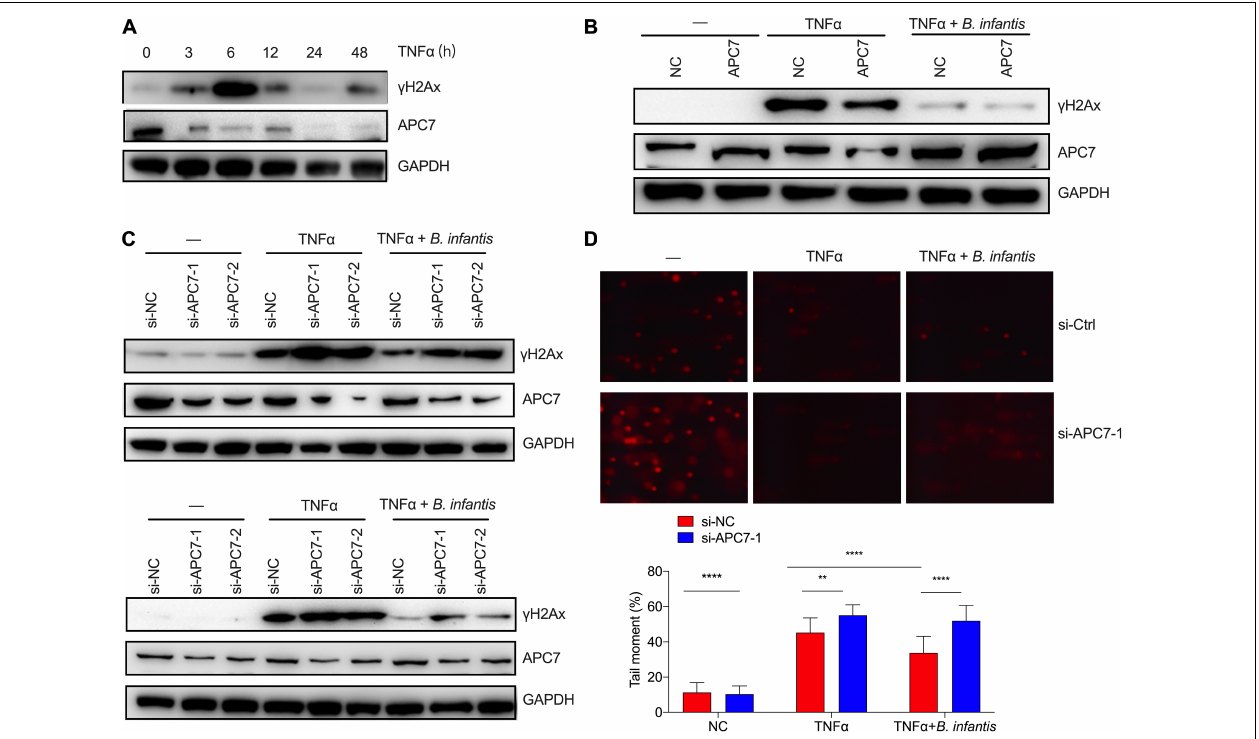
FIGURE 6 | Bifidobacterium infantis protected against genome stability partially by upregulating APC7 expression. (A) The expression level of APC7 and γ H2Ax were determined in TNF α -treated colon cells that had been co-cultured with B. infantis. (B) γ H2Ax levels were investigated by western blotting in APC7-overexpressing HCT116 cells co-cultured with B. infantis for 6 h. (C) The expression levels of γ H2Ax and APC7 were determined in APC7-knockdown colon epithelial cells, including HT29 (top) and HCT116 (bottom), co-cultured with B. infantis for 6 h. (D) The comet assay was used to determine DNA damage level in APC7-knockdown HT29 cells co-cultured with B. infantis for 6 h. (Magnification, × 20.) ** p < 0.01, **** p < 0.0001.